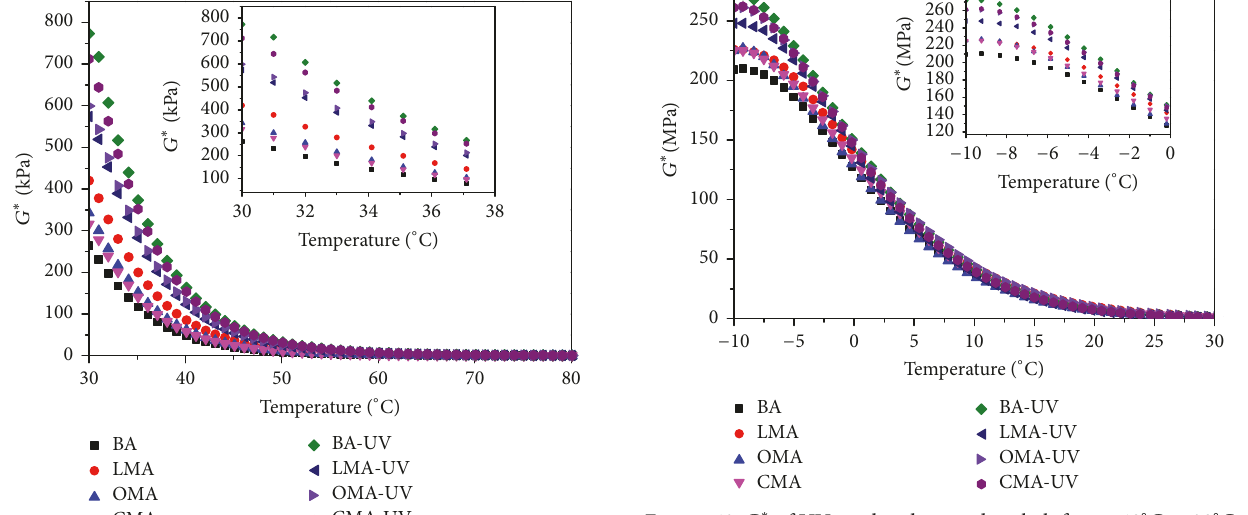
Figure 12: 𝐺 ∗ of UV aged and unaged asphalt from − 10 ∘ C to 30 ∘